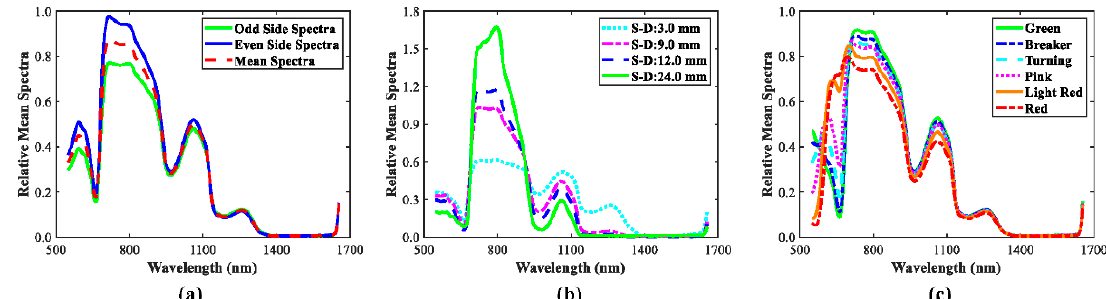
Figure 3. Mean reflectance spectra of tomatoes at turning stage for odd and even sides with source-detector distance of 6.0 mm and the mean spectra of these two spectra ( a ), the mean spectra with different source-detector distances for tomatoes at breaker stage ( b ), and the mean spectra at six maturity stages with the source-detector distance of 6.0 mm ( c ).